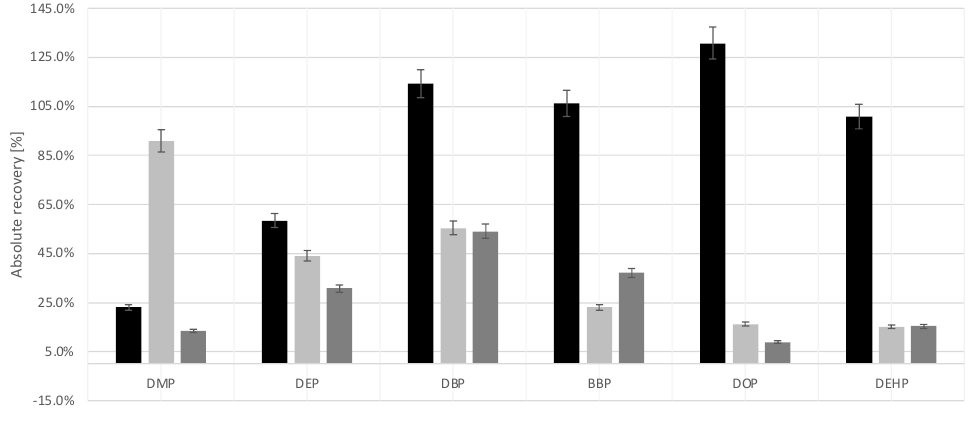
Figure 2. Absolute recovery (AR ± SD, %) of six target PAEs using different types of SPE cartridges (Oasis HLB, Strata C18-ec and Strata X; n = 3).